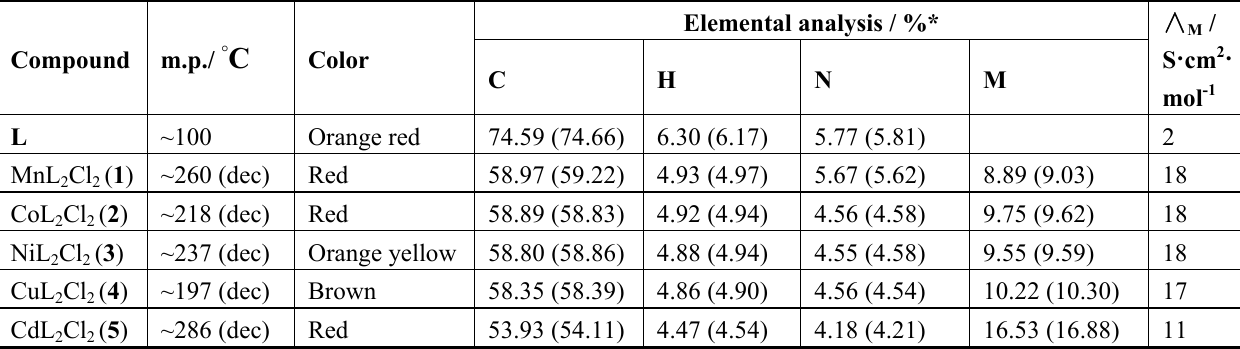
Table 1. Elemental analysis, molar conductance data of ligand and complexes.